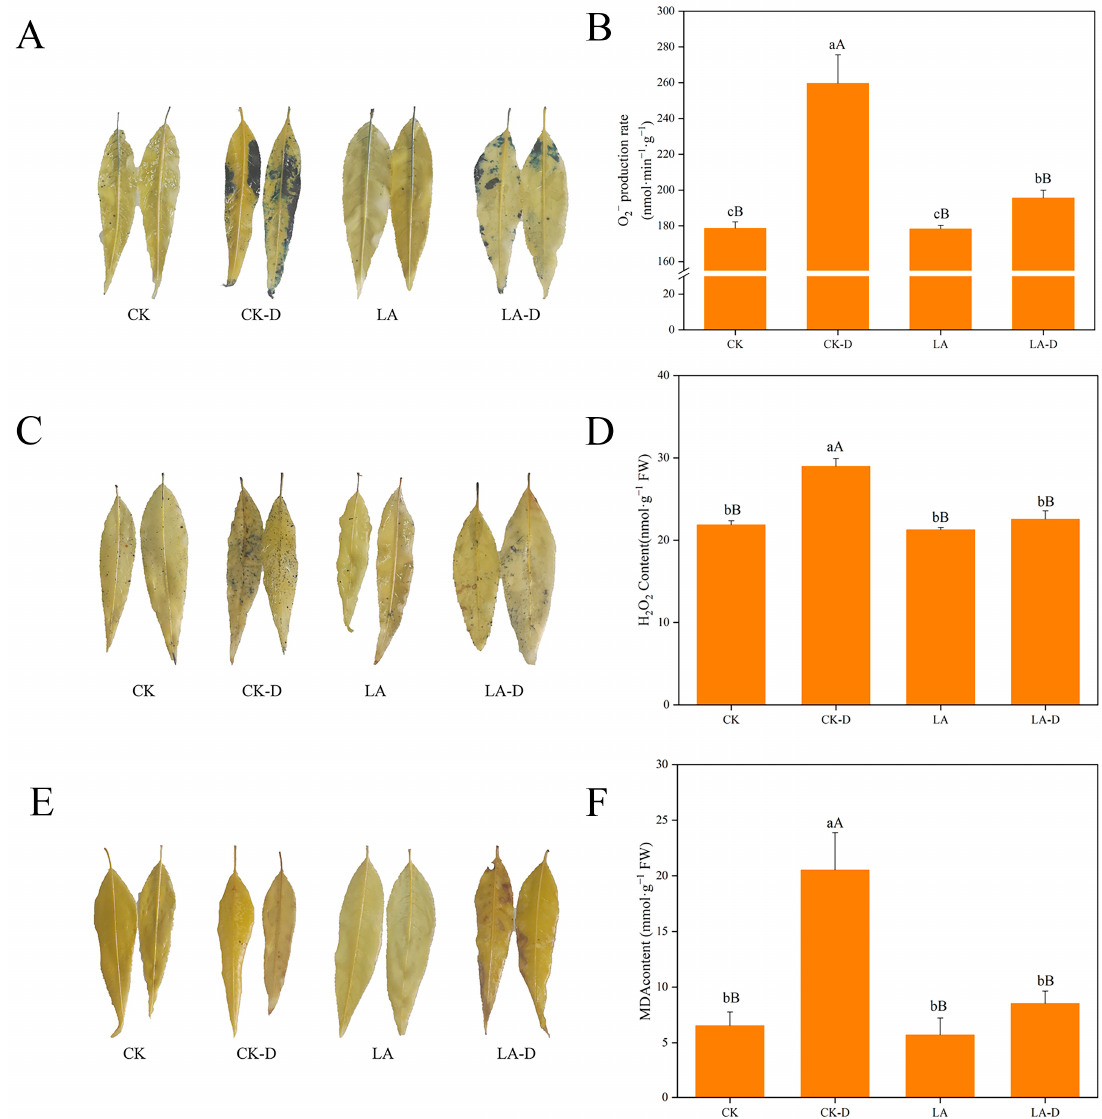
Figure 4. Effects of exogenous LA on cell death and ROS accumulation in leaves of P. persica under drought conditions. ( A ) Staining with Evans Blue, ( B ) effects of LA on O 2 − contents in leaves under drought, ( C ) staining with nitroblue tetrazolium (NBT), ( D ) effects of LA on hydrogen peroxide (H 2 O 2 ) content in leaves under drought, ( E ) staining with 3,3-diaminobenzidine (DAB), ( F ) MDA content. Values represent means ± SD of three replicates. Di ff erent le tt ers indicate signi fi cant di ff erences according to Duncan’s multiple range tests.